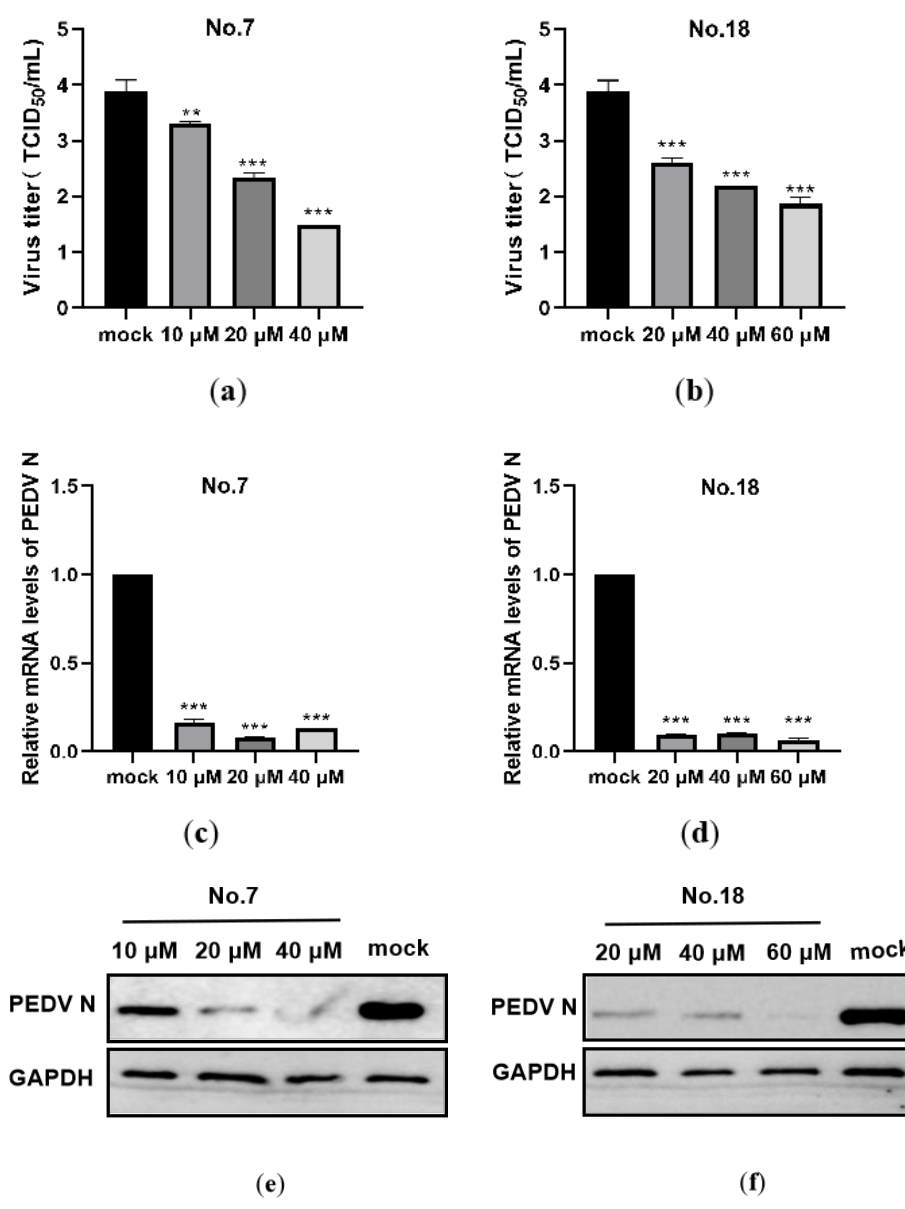
Figure 5. No.7, No.18 carbazole derivatives inhibited PEDV replication were in a dose-dependent manner. The vero-81 cells were incubated with increasing concentrates of carbazole derivatives (10, 20, 40 µ M for No.7 ( a , c , e ); and 20, 40, 60 µ M for No.18 ( b , d , f )) for 1 h, and then infected with PEDV for 2 h. Then, the cells were treated with the same concentration of carbazole derivatives for 24 h. ( a , b ) Cells were collected for RNA extraction, and the relative vRNA level was determined by qRT-PCR. ( c , d ) Supernatants were harvested to determine viral titer by TCID 50 . ( e , f ) Cells were lysed and subjected to western blot analysis. ** p < 0.01; *** p < 0.001.